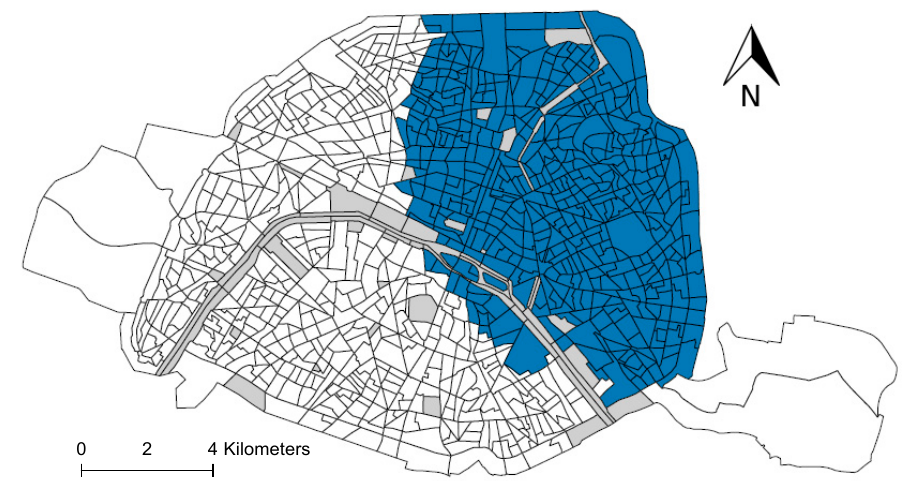
Figure 4. Mapping of the most likely cluster of the number of avoidable deaths. Blue areas identify census block included in the most likely cluster.